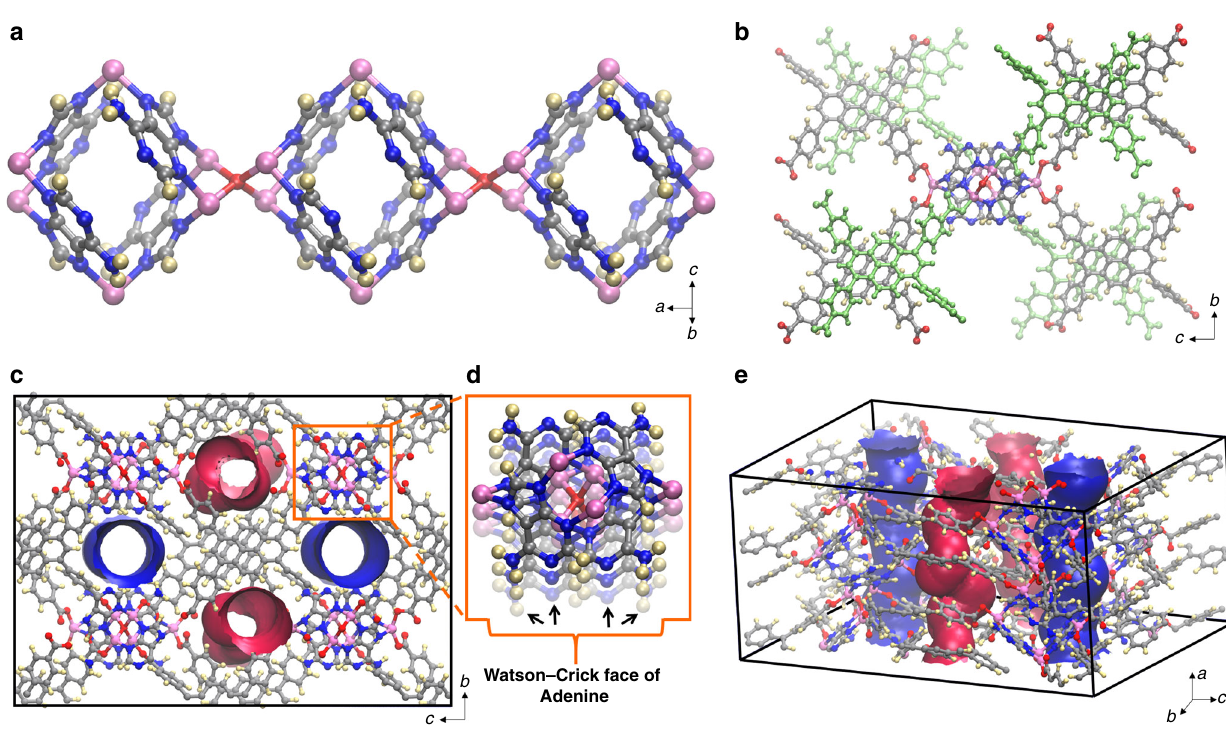
Fig. 1 Structural representation of SION-19. a A Zn II (adeninate) octahedron cage is coordinated to six Zn II ions, four at the corners of the equatorial plane (Zn II eq ) and two at the apical positions (Zn II ap ). The Zn II (adeninate) cages are linked to each other via the Zn II eq to form 1-dimensional columnar building blocks. b The Zn II (adeninate) columnar building blocks are linked to each other via fully deprotonated TBAPy ligands — gray TBAPy is bound to Zn II ap whereas the lime green is bound to Zn II eq . c , d Connolly surface representation of SION-19 viewed along the a -axis, revealing that the coordination of TBAPy ligands to the Zn II (adeninate) columns leads in the formation a 3-dimensional structure possessing two distinct types of 1-dimensional pores: the base-pore (blue) and the acid-pore (red). Highlighted in ( d ) are the Watson – Crick faces of Ade which point into the base pore and e Connolly surface representation of SION-19 in a 3-dimensional view. Atom color code: pink, Zn; red, O; blue, N; gray, C; light yellow, = γ = 90°, V = 14902.6 Å 3 , Ccce space-group symmetry, and fi t indicators of R wp = 4.8% and χ 2 = 2.3. Both EA and X-ray pho-